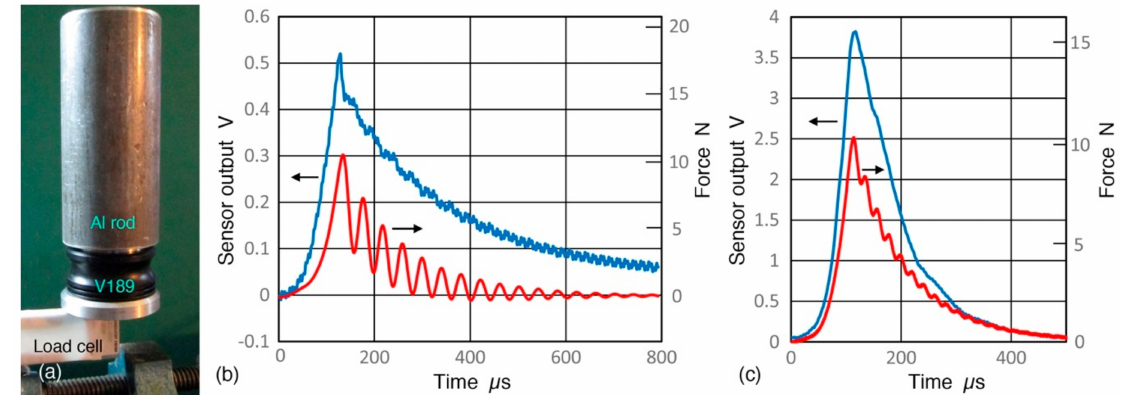
Figure 27. ( a ) Unloading test set-up; ( b ) Waveforms of sensor output by rapid unloading of 10.7 N using 100 M Ω input impedance (blue curve) and force (red curve). 100 Hz low-pass filter was inserted. V189 transducer; ( c ) Same as ( b ) with PZT-5A disk.